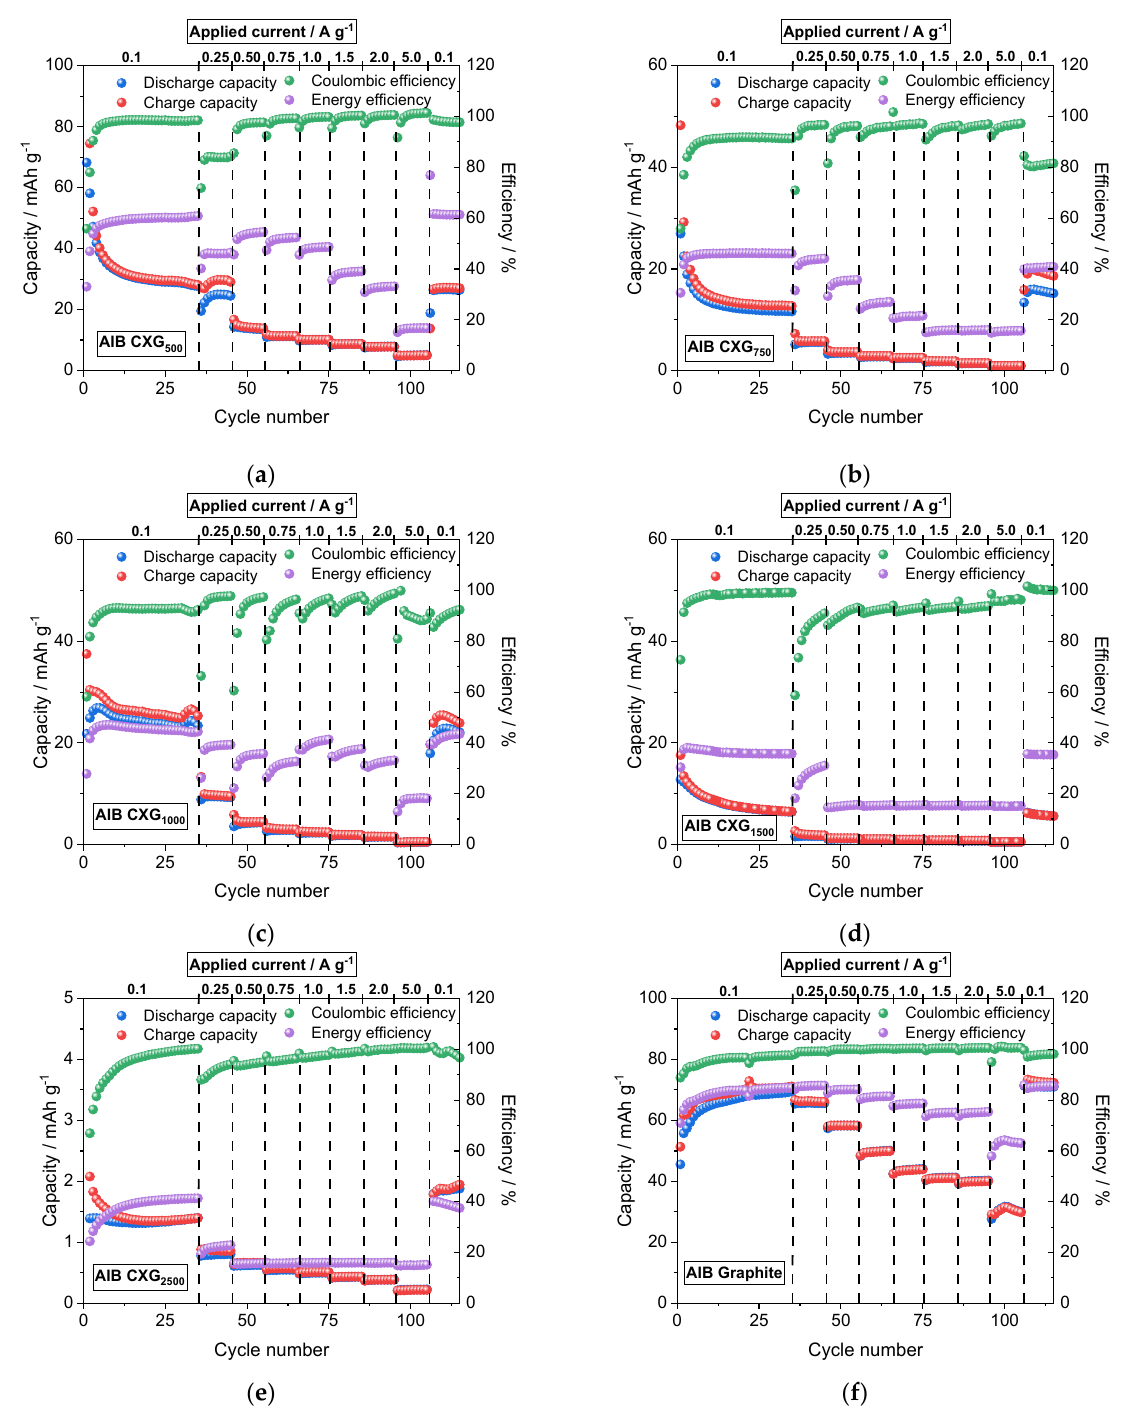
Figure 8. Charging/discharging experiments of CXG 500 ( a ), CXG 750 ( b ), CXG 1000 ( c ), CXG 1500 ( d ), CXG 2500 ( e ) and natural graphite ( f ) in Swagelok-type straight-cells with tungsten as cathodic current collector and aluminium rod as anode in n(EMimCl): n(AlCl 3 ) 1:1.5 electrolyte. The 35th charge/discharge cycle carried out at 0.1 A g − 1 of the different AIB cells is shown in Figure 9. Among the carbon xerogel materials, AIB with CXG 500 showed a discharge capacity of 28 mAh g − 1 at 0.1 A g − 1 that can be attributed to its high mesoporous volume. With decrease in V mes , the discharge capacity of AIB faded to 12–23.3 mAh g − 1 in AIBs with CXG 750 and CXG 1000 , and even lower for materials with R/C values > 1500 (7–1 mAh g − 1 ). The discharge capacity of AIB with NG amounted to 69 mA g − 1 . With the